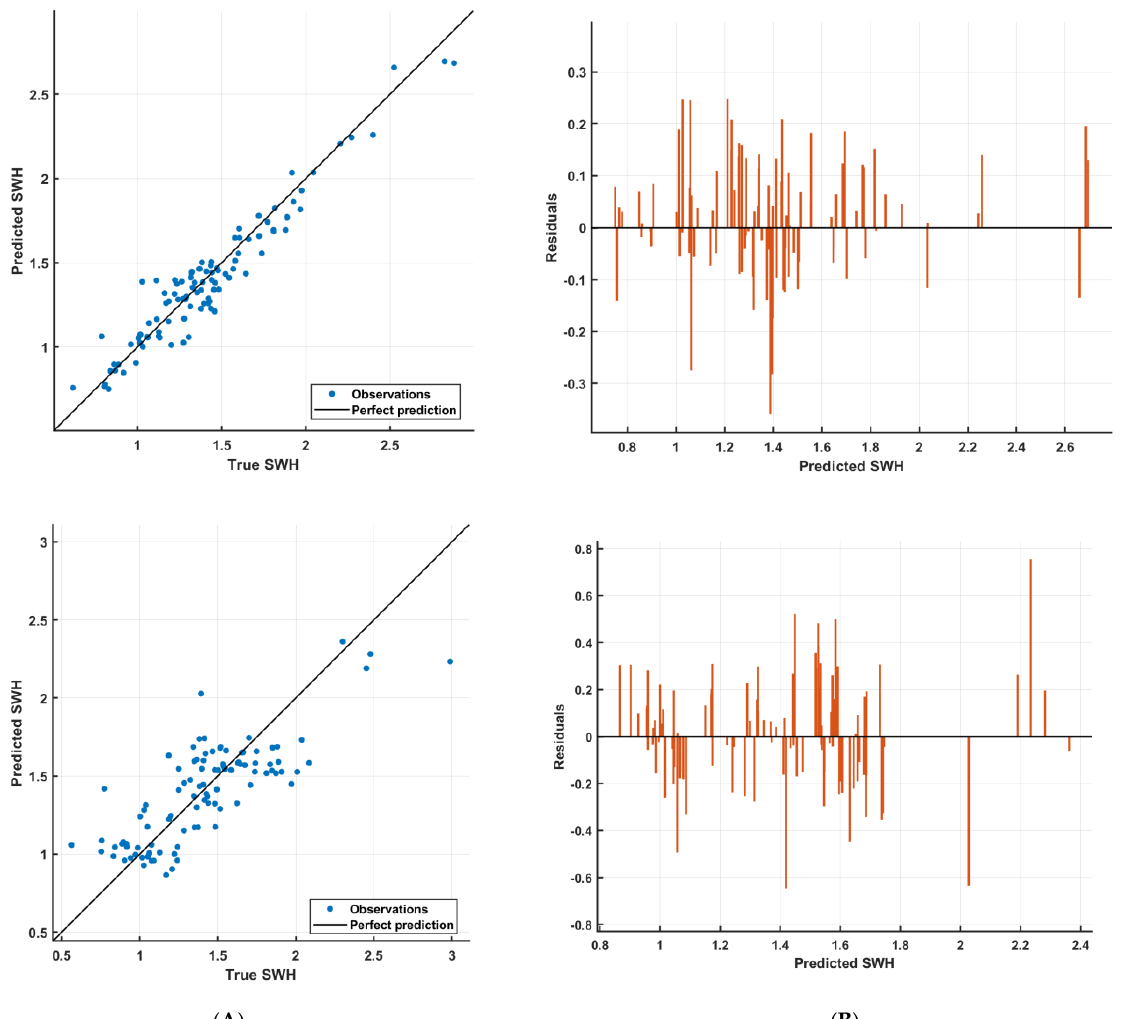
Figure 6. Testing prediction performance of the best performing regressors trained on the KU-based features of P0 data. ( A ) Predicted versus true SWH; ( B ) residuals versus predicted SWH; upper row: GPR model based on HAT-2; lower row: NNR model based on